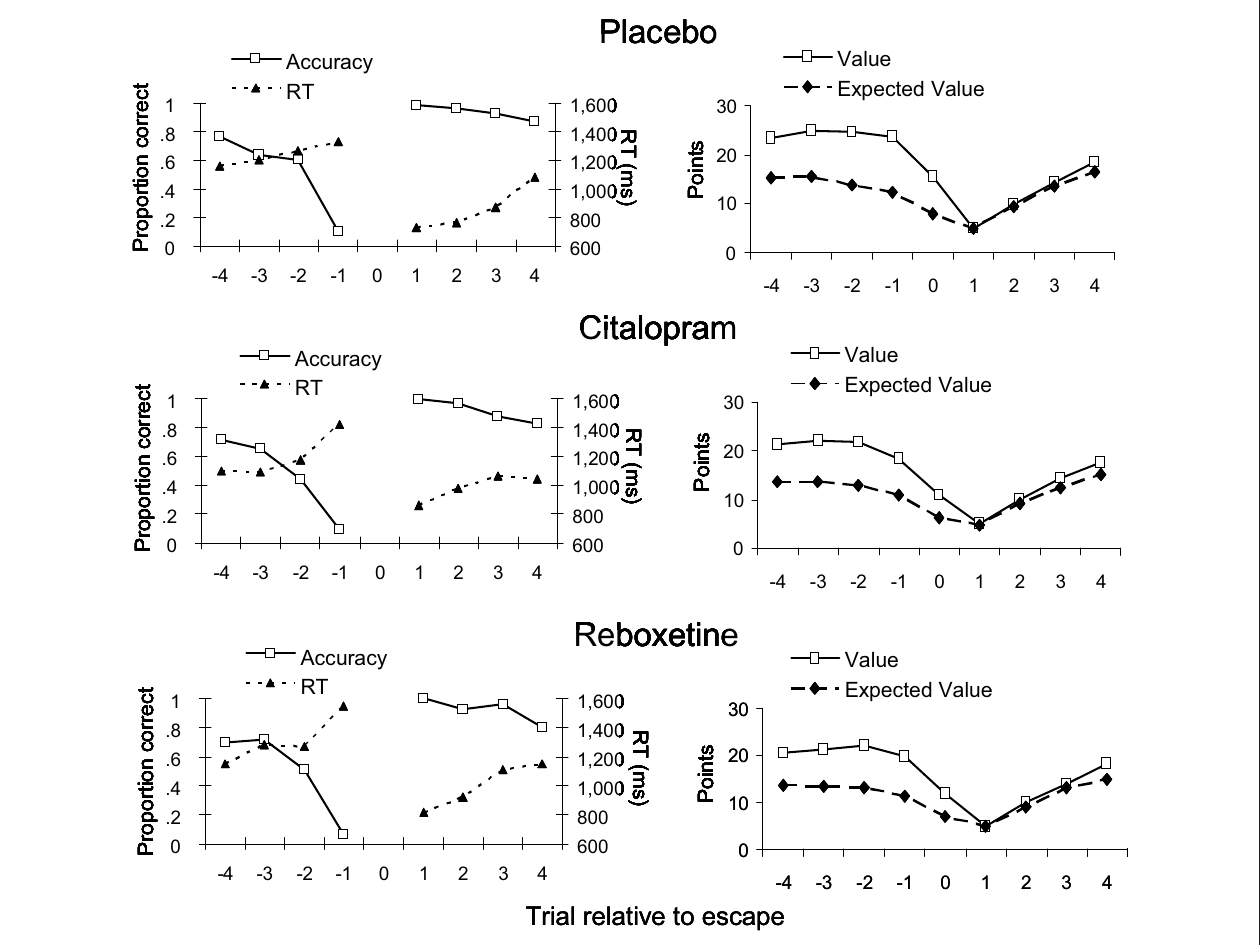
Figure 4 | Dependent measures for peri-escape trials in the three treatment groups. Trial number “0” indicates the escape trial. Left panels: accuracy and response time (RT). Right panels: Trial value and its computed expected value. Note that no measures of accuracy and RT are available for escape trials, because, on these trials, no comparison tone was presented.